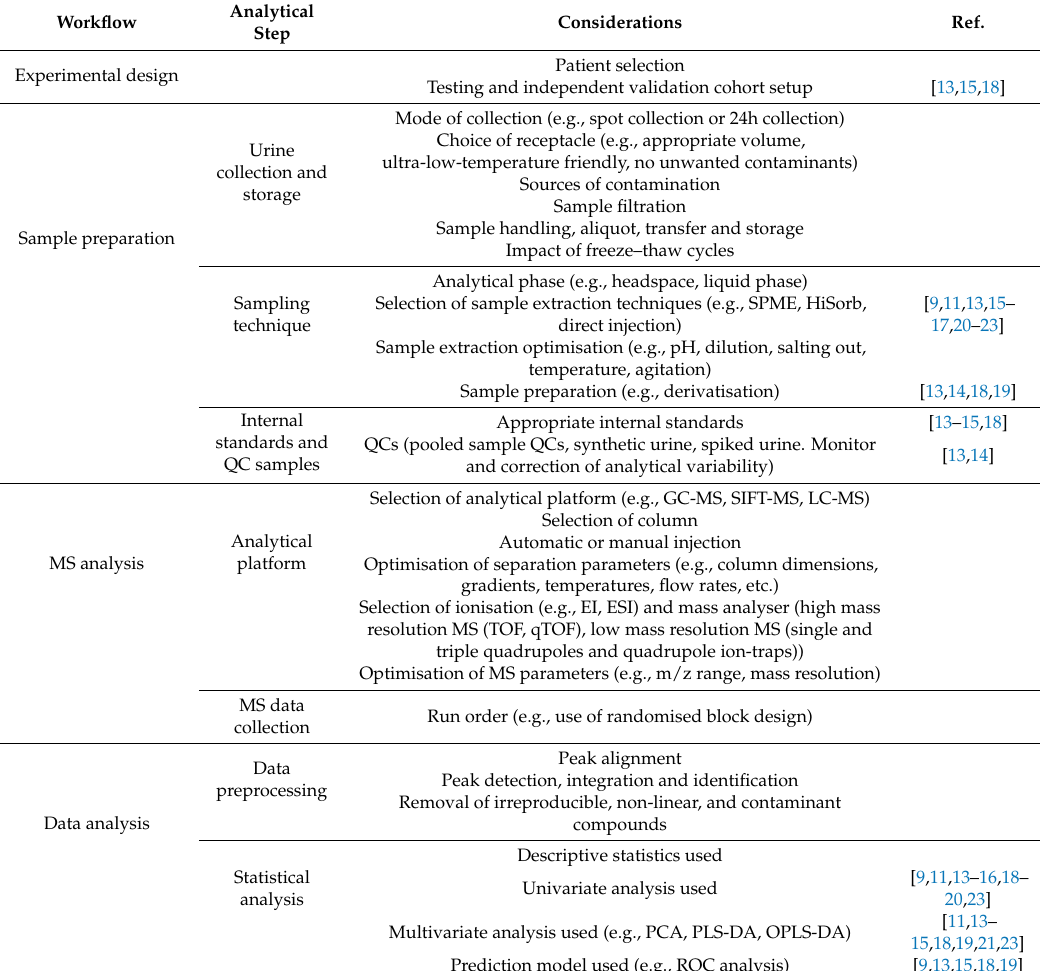
Table 4. Considerations for analysis of urinary volatile organic